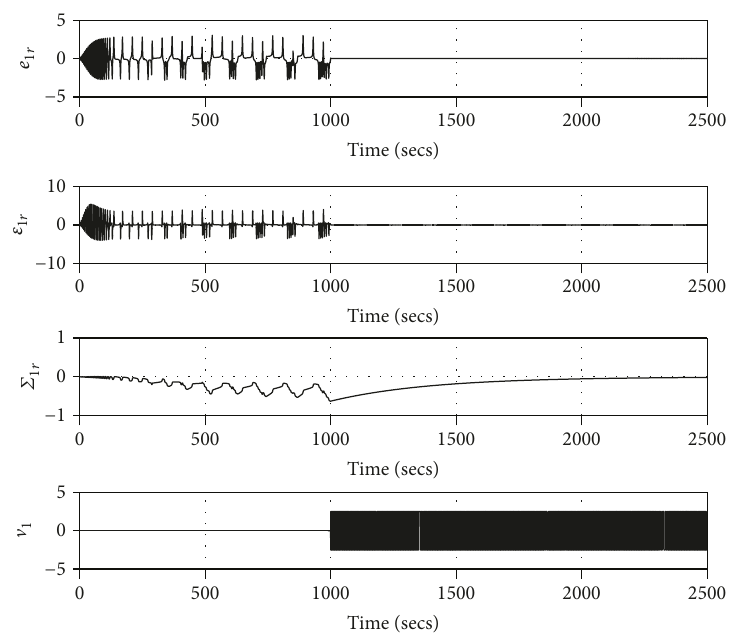
Figure 5: Trends of synchronization errors between Σ